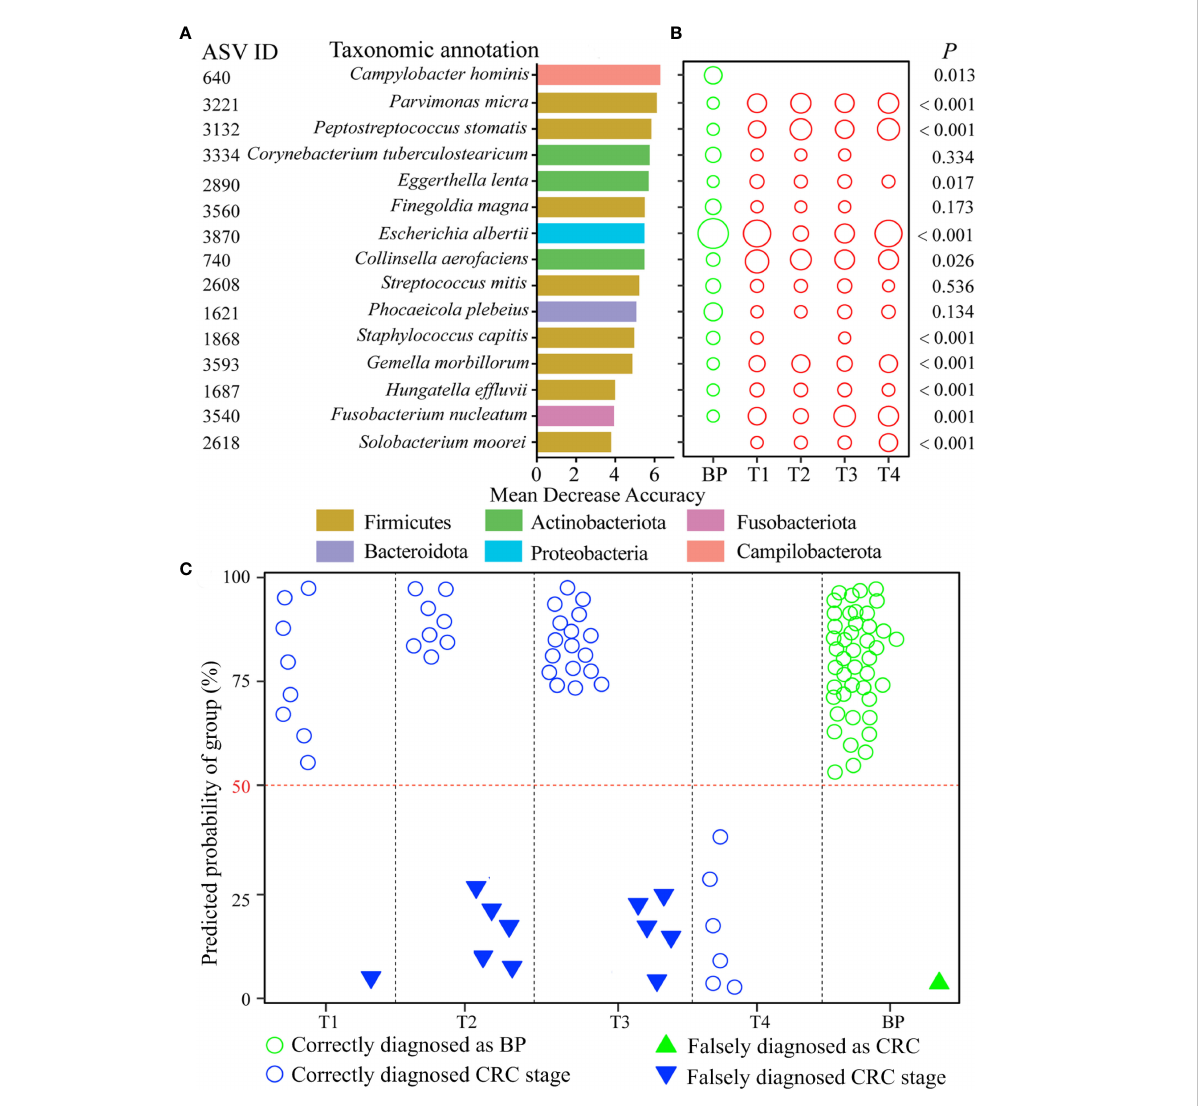
FIGURE 5 CRC diagnosis model using the CRC stage-discriminatory taxa. The top 15 CRC stage-discriminatory ASVs are ranked in descending order of importance to the accuracy of the diagnose model (A) . The diameters of the circles are proportional to the relative abundances of the 15 biomarkers (B) . The diagnosed CRC stages using pro fi les of the 15 CRC stage-discriminatory ASVs. The consistency between observed and diagnosed stage was termed a correct diagnosis with a cutoff of 50% (C) . Refer to Figure 1 for